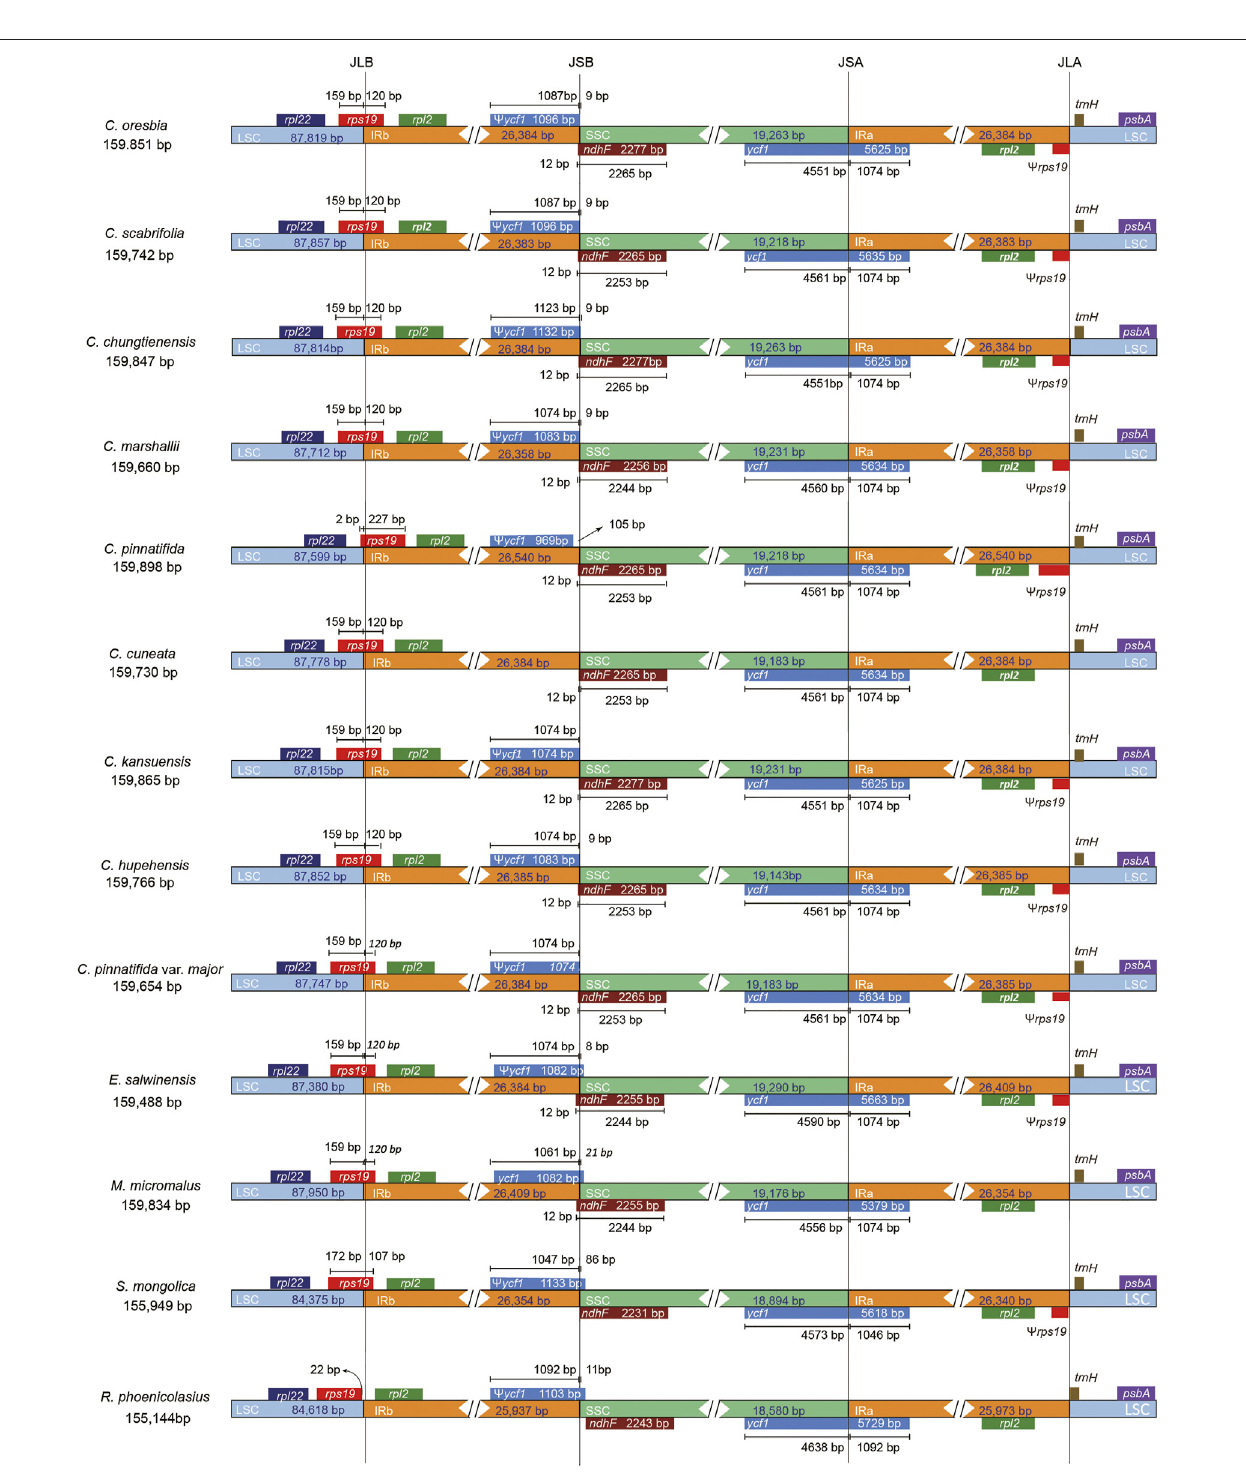
FIGURE 5 | Comparison of the borders of the LSC, SSC, and IR regions among 9 Crataegus chloroplast genomes and four species of Rosaceae.